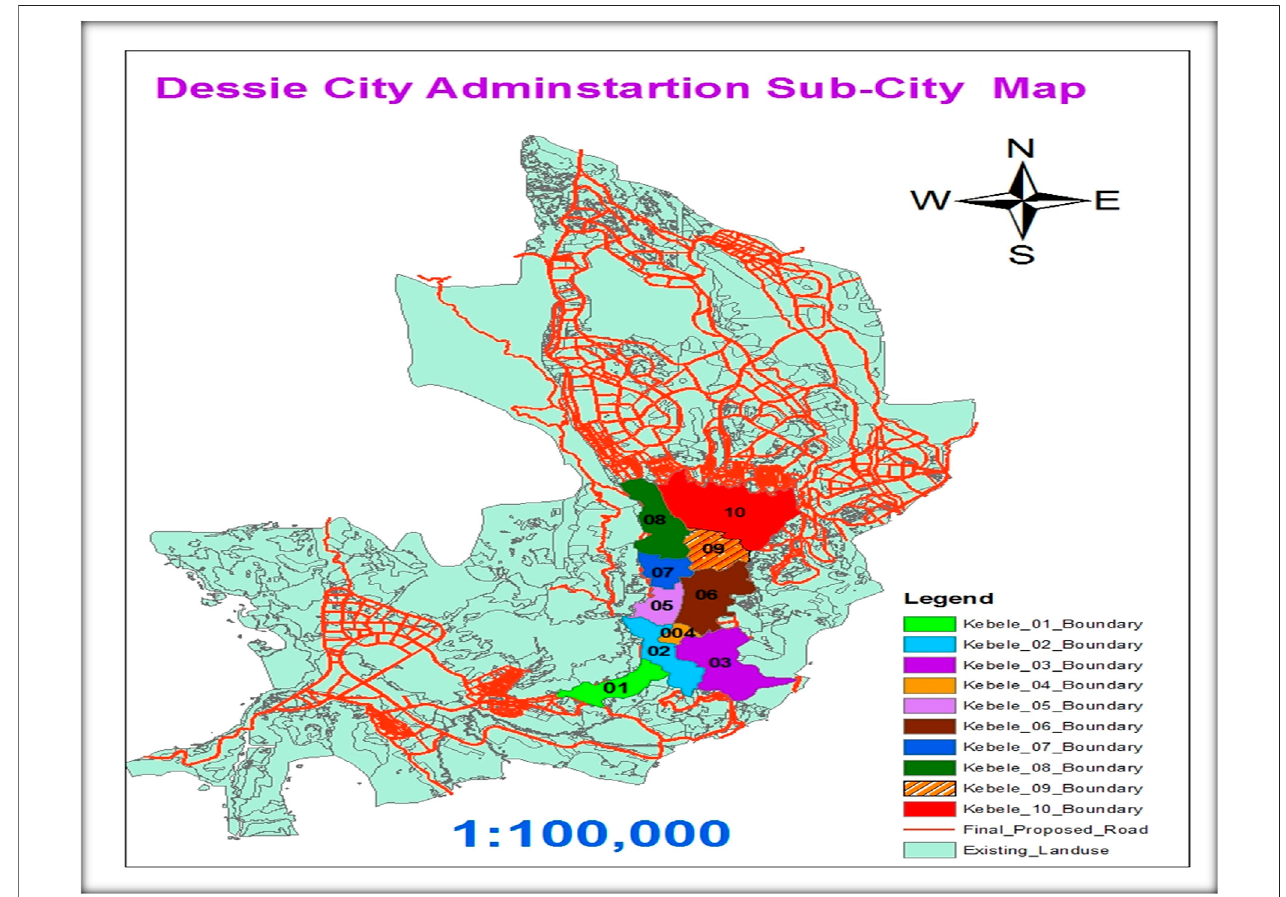
FIGURE 1 | Map of study